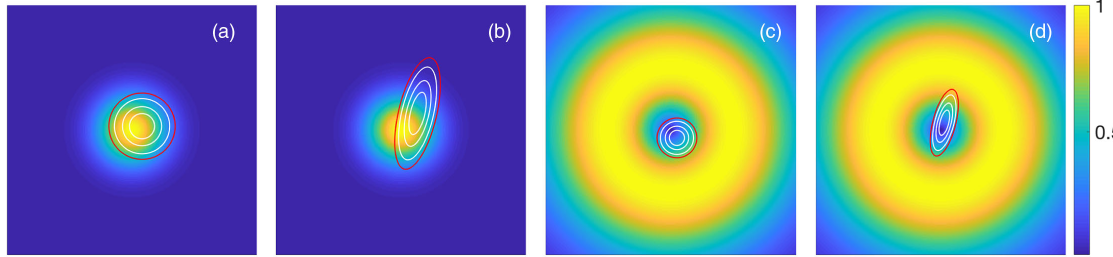
FIG. 1. LH and e-beam intensity distributions. The heat-map represents the laser intensity while the contour plot represents the probability distribution of the e-beam. The red line is the e − 1